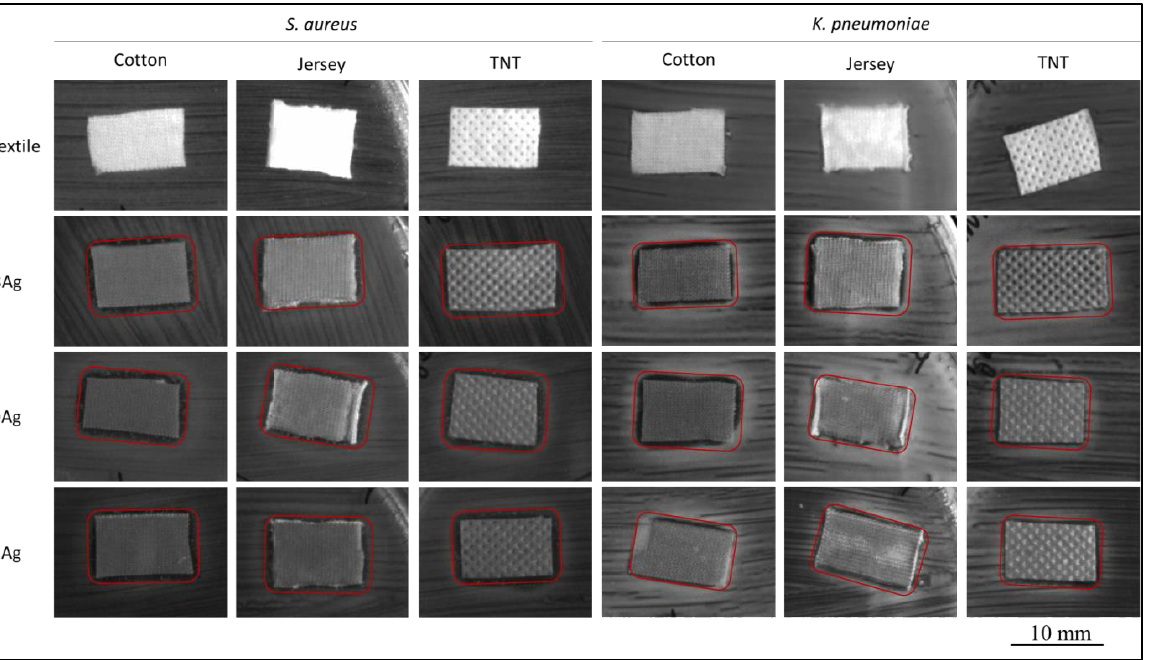
Figure 3. SEM images of the coated and uncoated fabrics after the zone of inhibition testing, a red line highlights the ZoI around the fabrics.